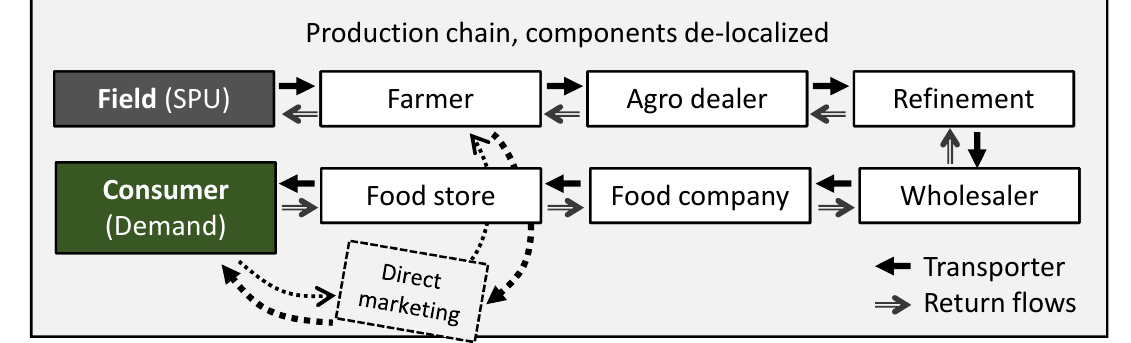
Figure 2: Complex ecosystem service supply chain, example of food provisioning services. Direct marketing could provide a more direct link. Several further ‘short-cuts’ between supply and demand are